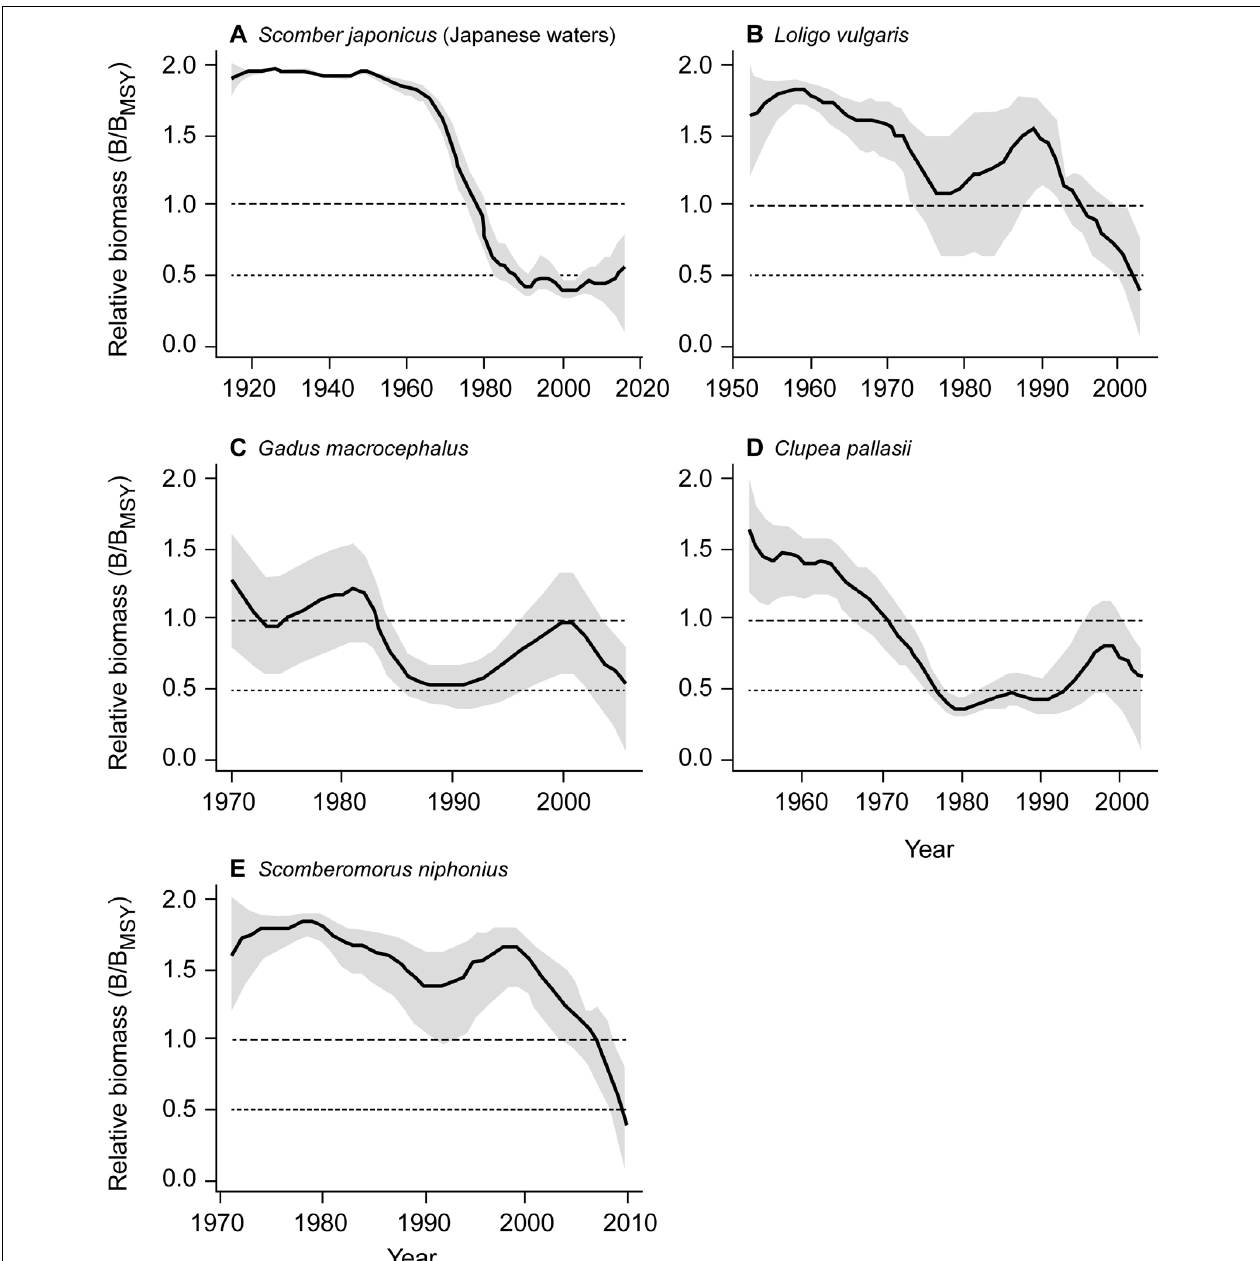
FIGURE 2 | Trend of relative biomass ( B/B MSY ) generated using the CMSY method for 5 stocks without CPUE data, with the gray areas referring to the 95% confidence intervals. Panels (A–E) thus illustrate assessments with a minimum of